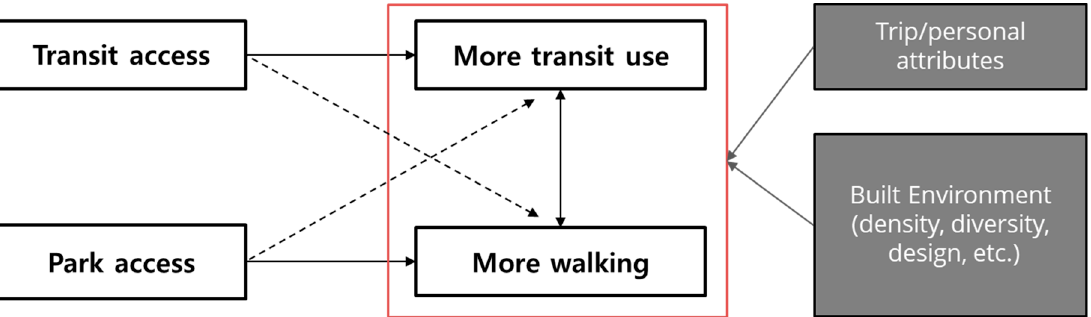
Figure 1. Conceptual framework of the relationship between a park near a station and travel behavior (solid line: Direct effect, dashed line: Indirect effect).